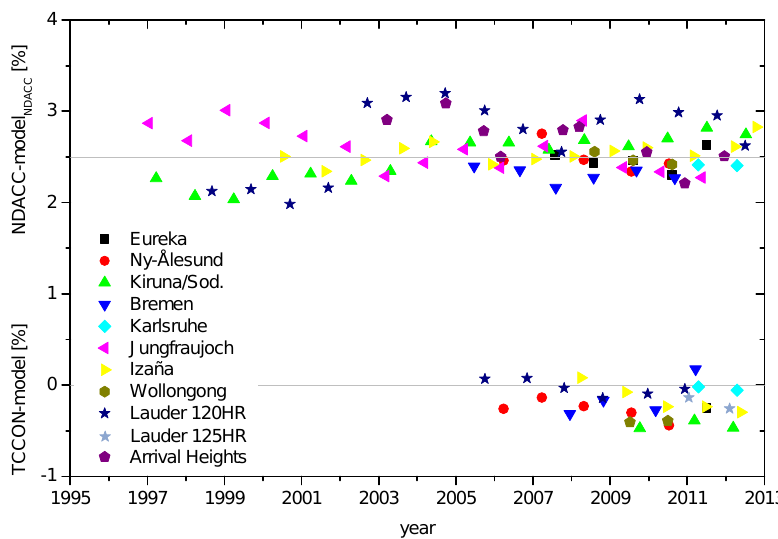
Figure 10. Time series of the differences of the yearly means between measurement and respective model. Top: NDACC-model NDACC , bottom: TCCON-model. the amplitude of the seasonal variations. We show that the re- spective damping of the seasonal amplitude can be described 675 by a consistent parametrisation for all the different sites and can be very easily considered in the model simulations. We apply the developed method to the NDACC/FTIR spectra that have so far been contributing to the project MUSICA. These spectra have been measured since 1996 680 at ten stations that are distributed around the globe. We found a scatter between the yearly mean NDACC data and the model of about 3‰. This provides strong evidence for the very good long-term data consistency between these NDACC/FTIR sites and is a good reliability and consistency 685 test for the long-term trends of tropospheric species mea- sured at these sites.